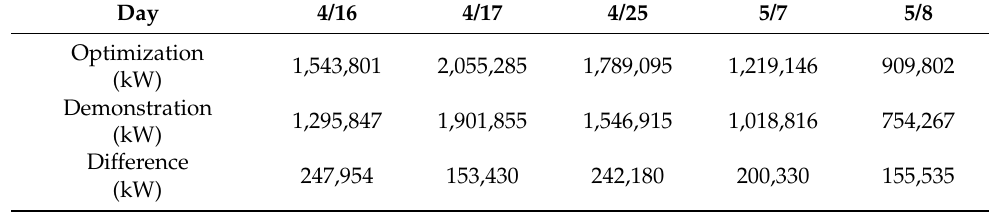
Table 5. Demonstration windfarm and Optimization windfarm power.